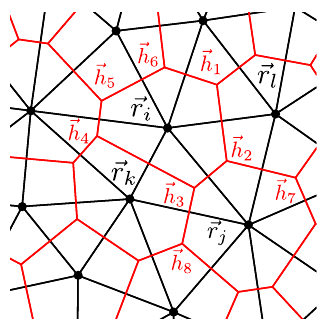
FIG. 6. Cell center positions are specified by vectors f ~r g . They form a Delaunay triangulation (black lines). Its dual is the Voronoi tessellation (red lines), with vertices given by f ~h g